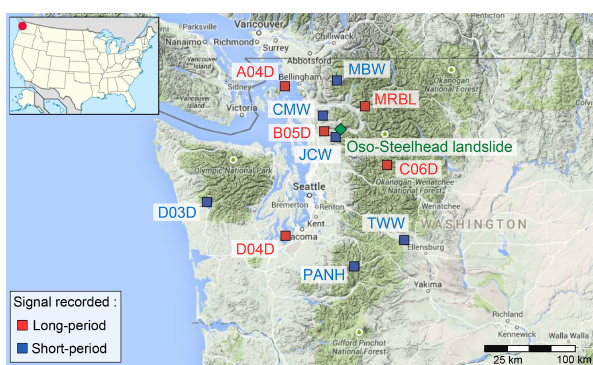
Figure 1. Map of seismic stations used in the investigation of the Oso-Steelhead landslides. Blue squares show stations with good short-period signals (1–10Hz); red squares show stations with good long-period signals (40–150s). The stations belong to the Pacific Northwest Regional Seismic Network (CMW, JCW, MBW and TWW), the USArray Transportable Array (A04D, B05D, C06D, D03D and D04D) and the Cascade Chain Volcano Monitoring net- work (PANH). Figure 2. Seismic signals recorded at the short-period station JCW,